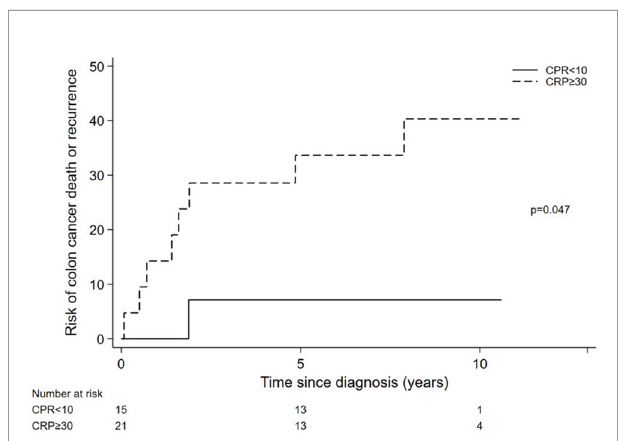
FIGURE 2 | Risk of recurrence or death from colon cancer in CRP high and low patients.